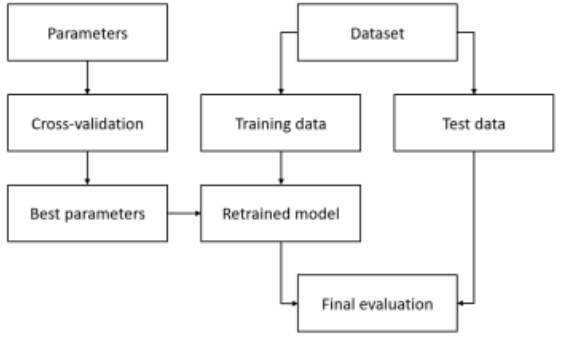
Figure 3. Workflow for tuning and training of the